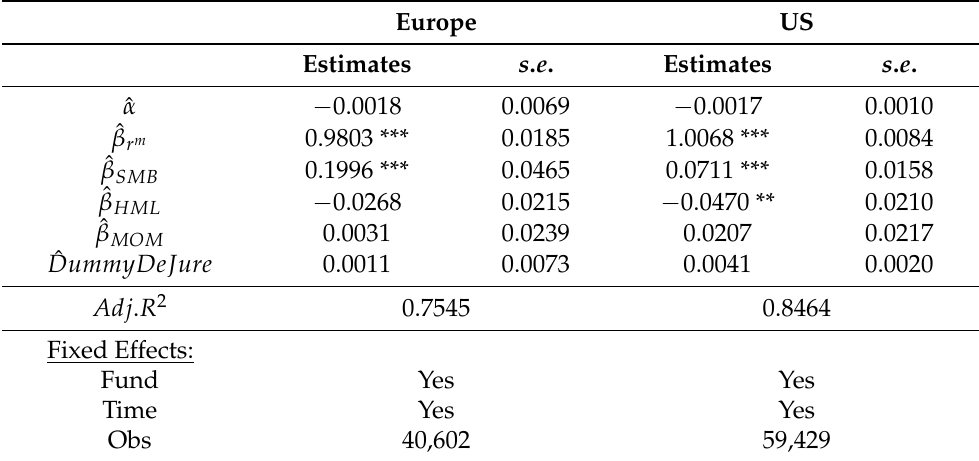
Table 6. Estimation of the panel version of Carhart’s model (2013–2018) with dummy de jure